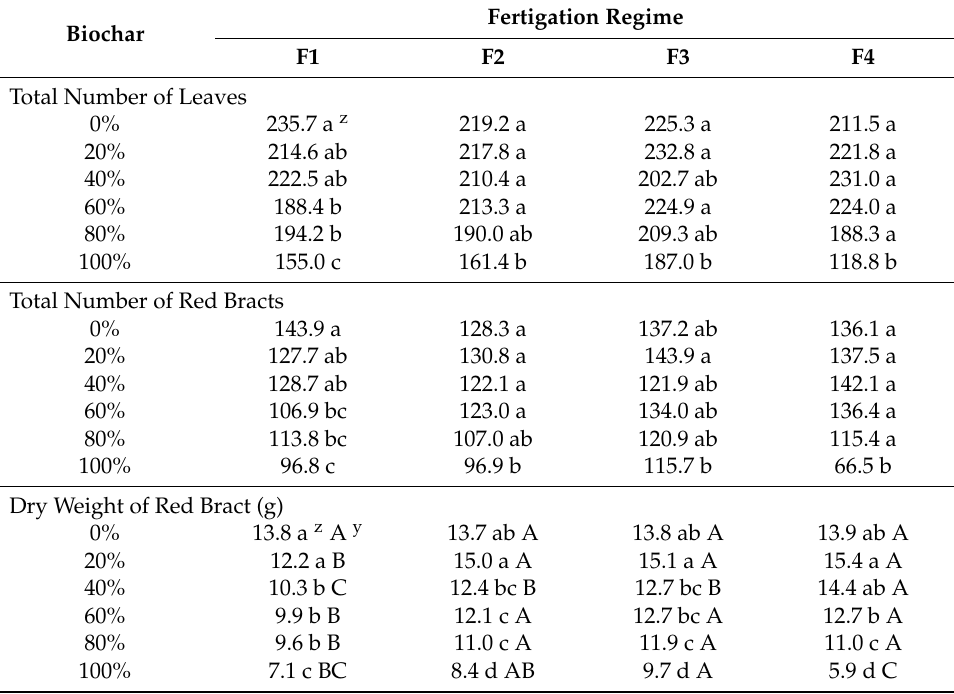
Table 5. The total number of leaves (green leaf + red bract), the total number of red bracts, and red bract dry weight of ‘Prestige Red’ poinsettia 15 weeks after transplanting in Sunshine Mix #1 amended with six different percentages of biochar and fertigated at four different regimes. All data were collected at 15 weeks after